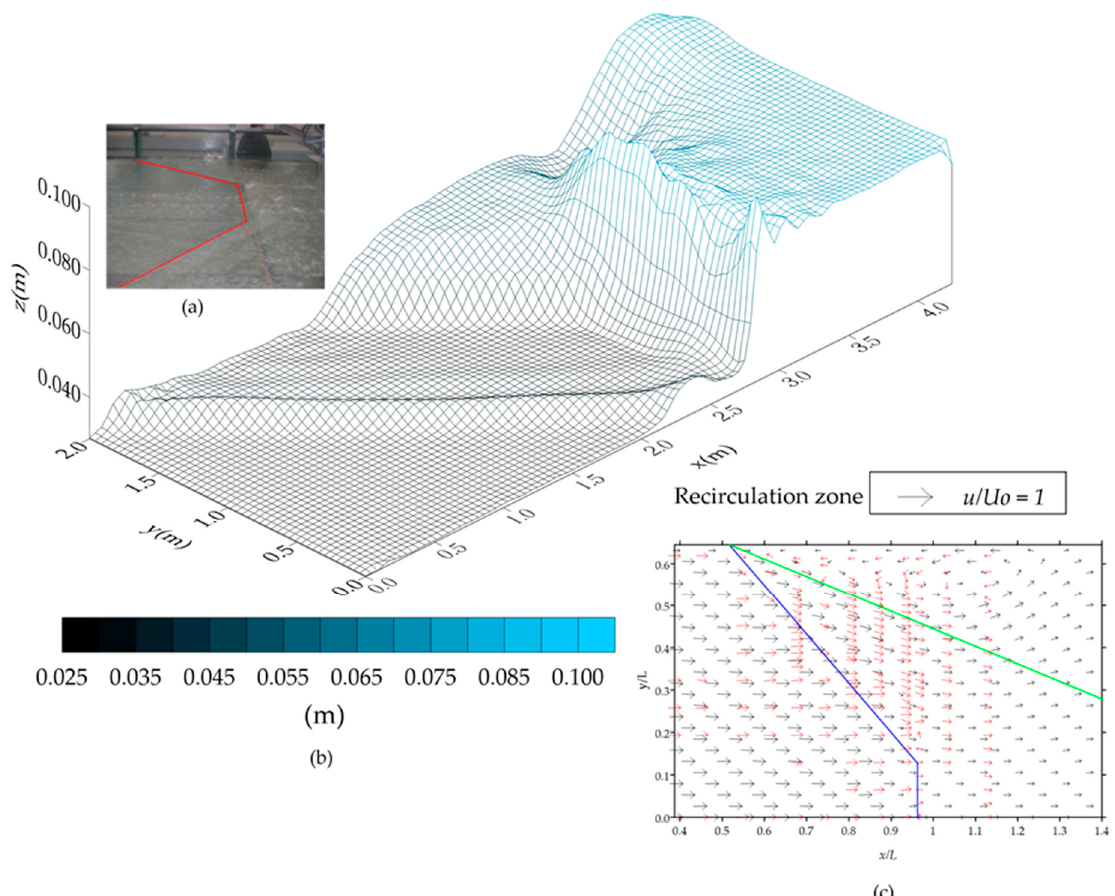
Figure 6. SPH simulation of hydraulic jump in a very large channel: ( a ) picture of experiment; ( b ) wave-height distribution and ( c ) velocity vector fields.